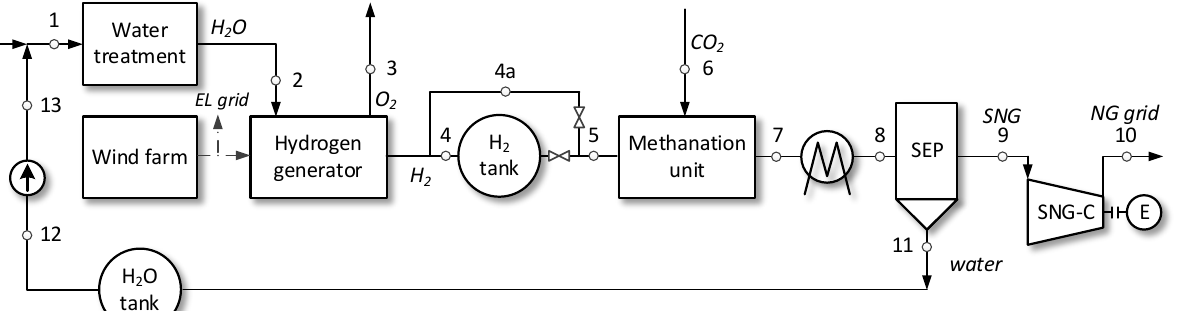
Figure 1. Scheme of the power to SNG system.